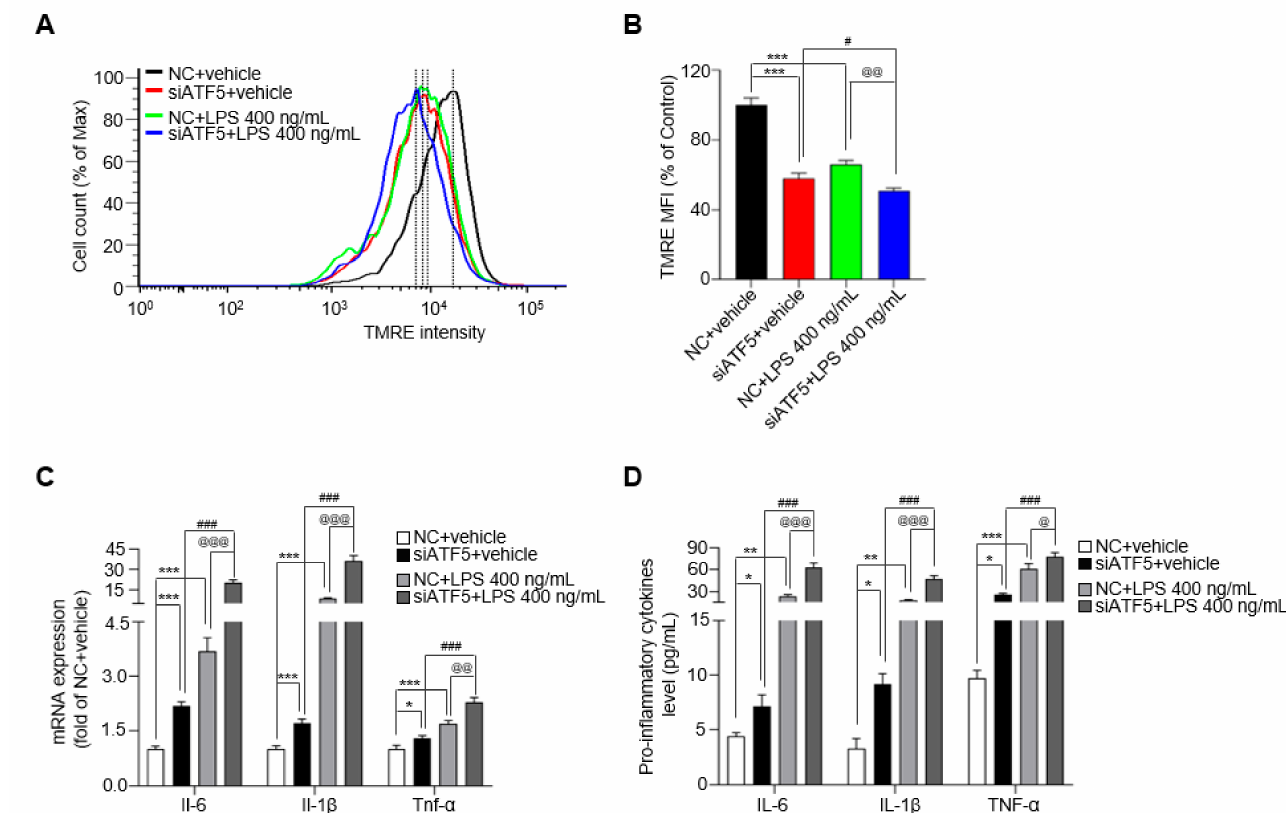
Figure 4. siATF5 upregulates the secretion of pro-inflammatory cytokines with downregulates mi- tochondrial membrane potential (MMP). ( A ) The MMP determined by TMRE-stained BV-2 cells. ( B ) Median fluorescence intensity (MFI) values analyzed by the FlowJo 7.6 program. ( C ) The expres- sion of Il-6 , Il-1 β , and Tnf- α in NC- or siATF5-treated for 24 h and vehicle- or LPS-treated BV-2 cells for another 48 h. ( D ) The protein level of IL-6, IL-1 β , and TNF- α as determined by ELISA. Data are presented as mean ± SEM of three independent experiments (* p < 0.05, ** p < 0.01, *** p < 0.001 compared to NC+vehicle, # p < 0.05, ### p < 0.001 compared to siATF5+vehicle, @ p < 0.05, @@ p < 0.01, @@@ p < 0.001 compared to NC+LPS 400